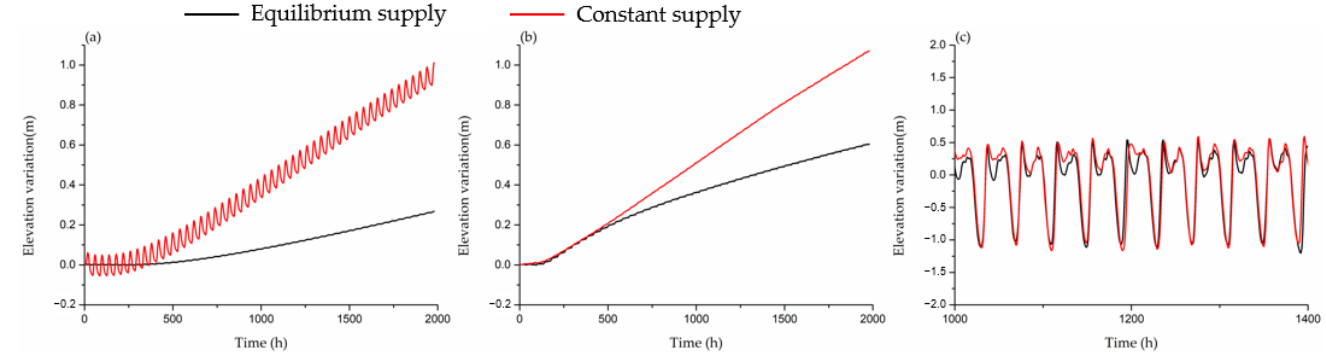
Figure 9. Elevation variation comparison of three specific points in three zones. ( a ) The point 900 m downstream in the HBL zone. ( b ) The point 2400 m downstream in the buffer zone. ( c ) The point at 9000 m downstream in the bar zone (i.e., to make the comparison clear, the time range from 1000 to 1400 h is selected).